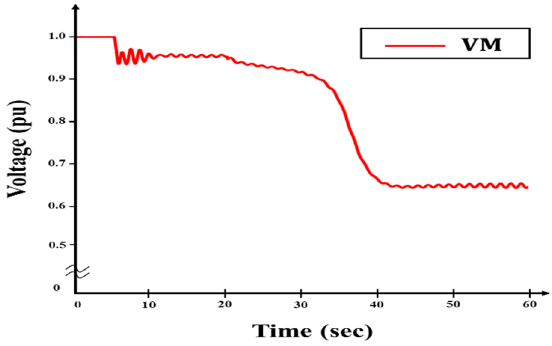
Figure 13. Voltage magnitude variation of virtual bus.